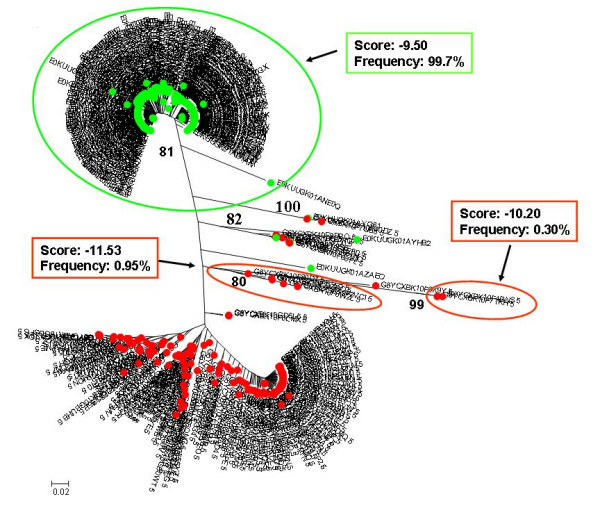
Individual phylogenetic tree of HIV-1 V3 amino acid sequences from Pt.1. Proviral quasispecies harboured by monocytes (red circle = CD36-provirus) and T lymphocytes (green circle = CD26-provirus) of Pt.1 were analyzed after long term suppression of viremia. Nucleotide sequences obtained by ultra-deep pyrosequencing were translated in amino acid sequences and filtered through the correction algorithm described in the Material and Methods section. Unique sequences for each sample type were used to build phylogenetic trees with the neighbour-joining method. Bootstrap values ≥ 80% are shown. The cellular sources of proviral and viral sequences are indicated by coloured bullets. Sample type-specific cluster with bootstrap values ≥ 80% are encircled with the corresponding colours. PSSM score was calculated for each of these clusters, and the corresponding values are included in the insert, together with their relative abundance in the corresponding sample type. Bars indicate p distance scale.